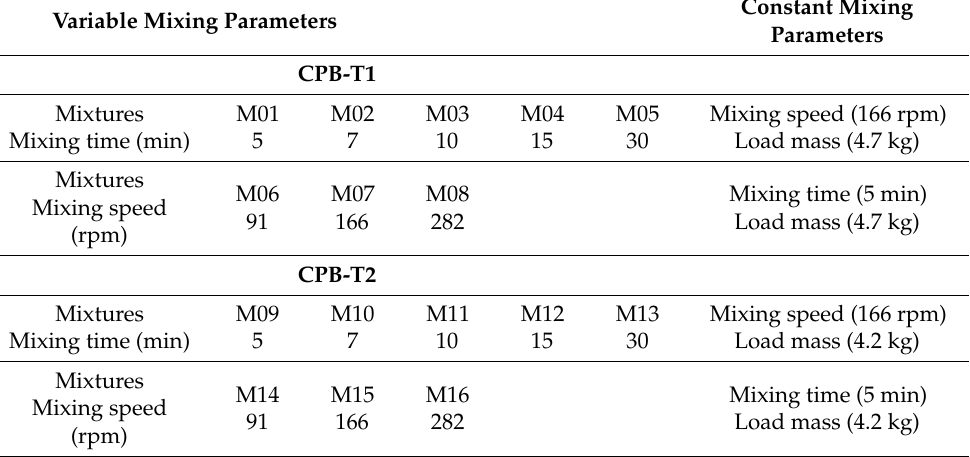
Table 1. Mixtures used to investigate the influence of specific mixing energy (SME) on rheological and mechanical properties of cemented paste backfill (CPB) prepared with CPB-T1 and